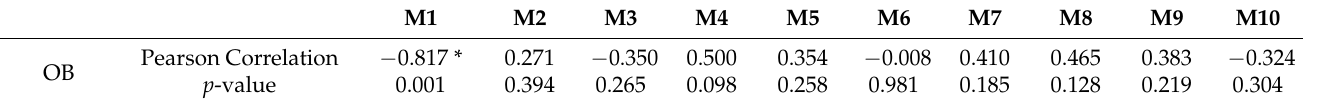
Figure 4. Co − occurrence patterns of continuous cropping obstacle sensitive ASVs and ecological cluster. ( A ): Co − occurrence networks visualizing significant correlations (r > 0.8, p < 0.05; indicated with gray lines) between bacteria and fungi ASVs in rhizosphere soil communities. ( B ): Cumulative relative abundance (as counts per million, CPM; y-axis in × 1000) of all bacteria and fungi of the continuous cropping obstacle susceptible modules in the networks. Asterisk (*) indicates significant differences ( t -test method, p < 0.05). Error bars are standard errors. Table 1. Correlation between above-ground biomass of tobacco and co-occurrence networks ecologi- cal clusters